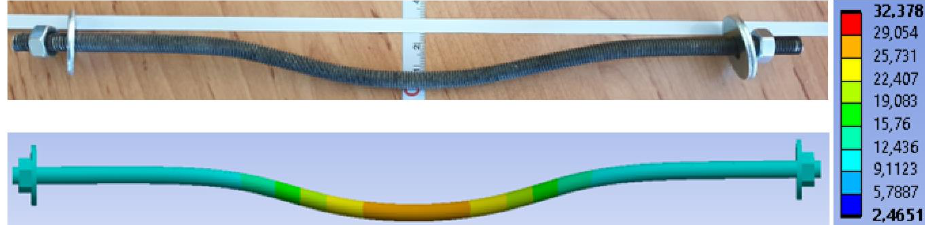
Figure 20. Deformation of a bolt (mm).